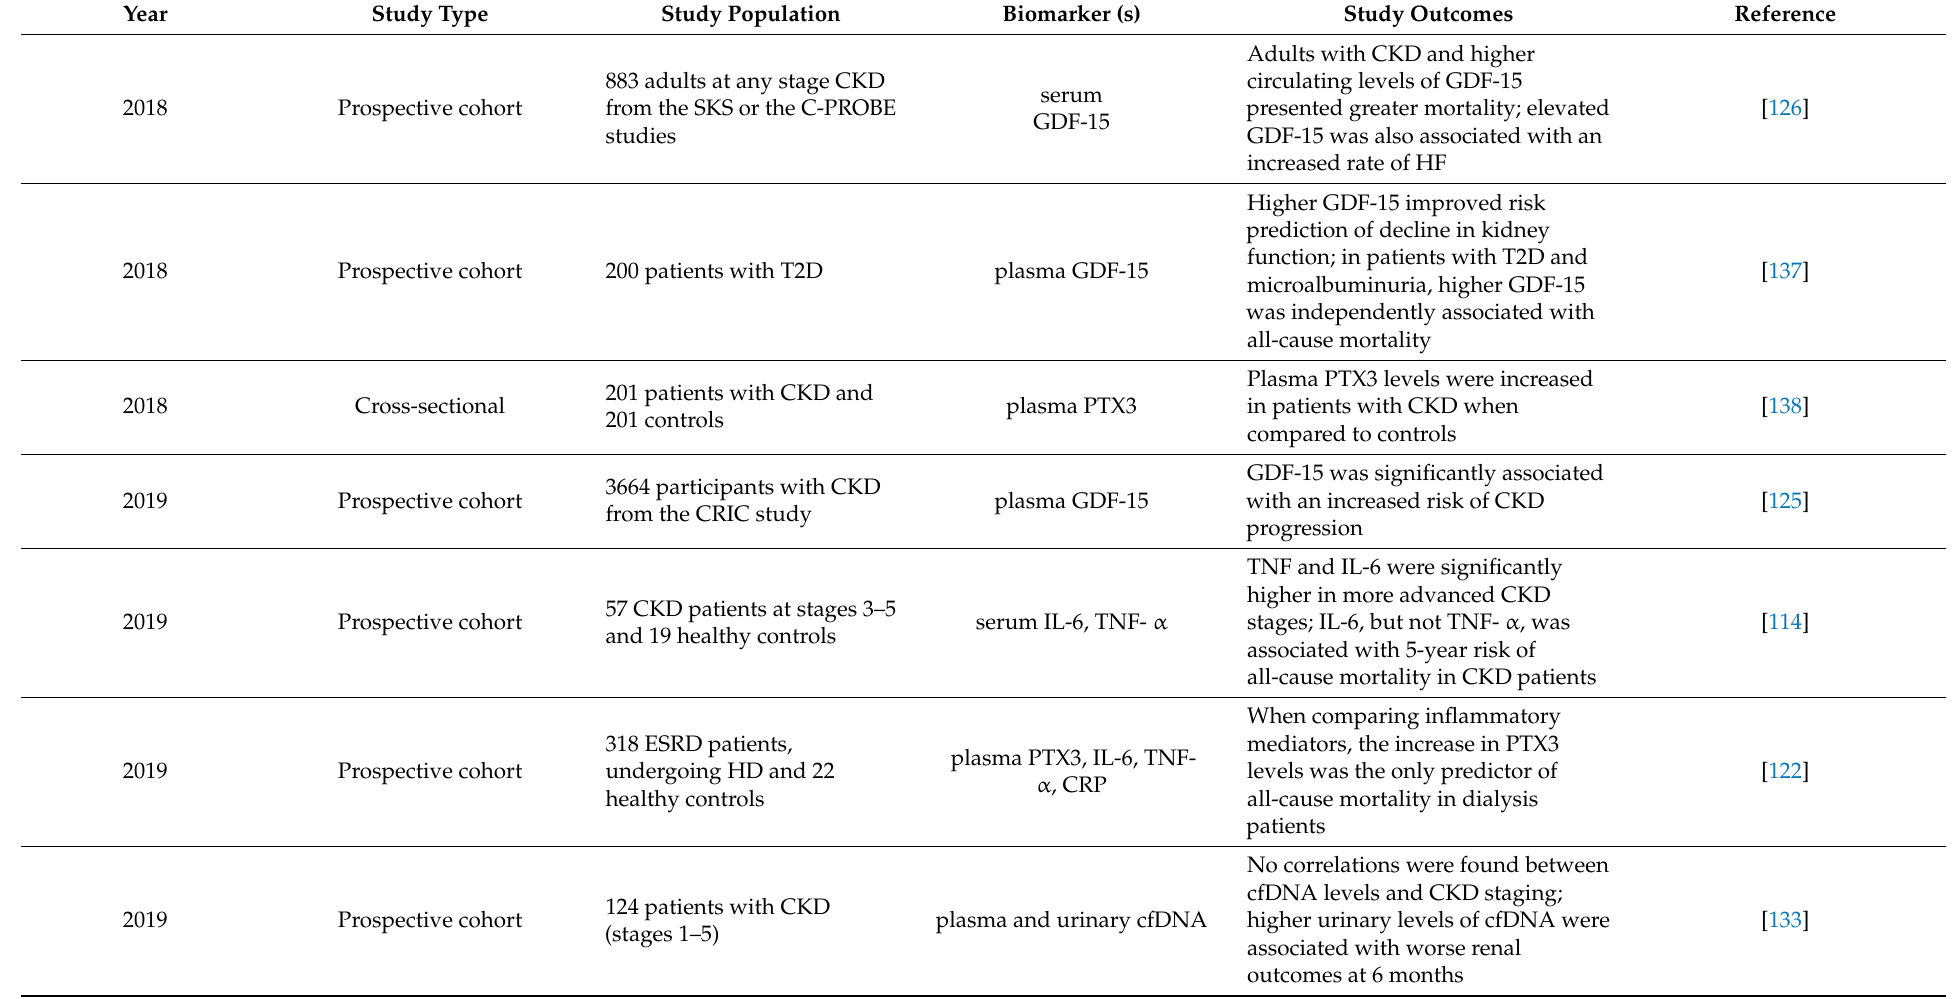
Table 4. Research studies on biomarkers of inflammation and main outcomes in CKD